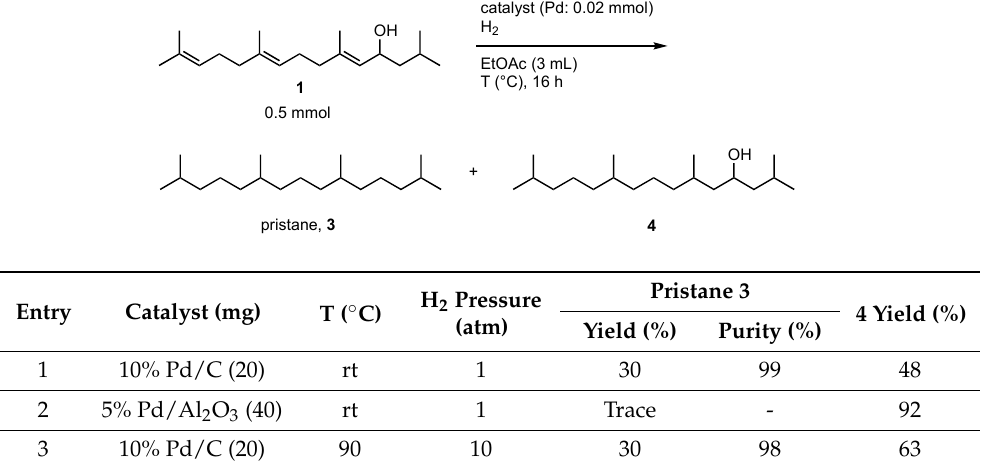
Table 1. Batch synthesis of pristane 3 by dehydrative hydrogenation of 1 using a Pd/C Catalyst under a H 2 atmosphere.